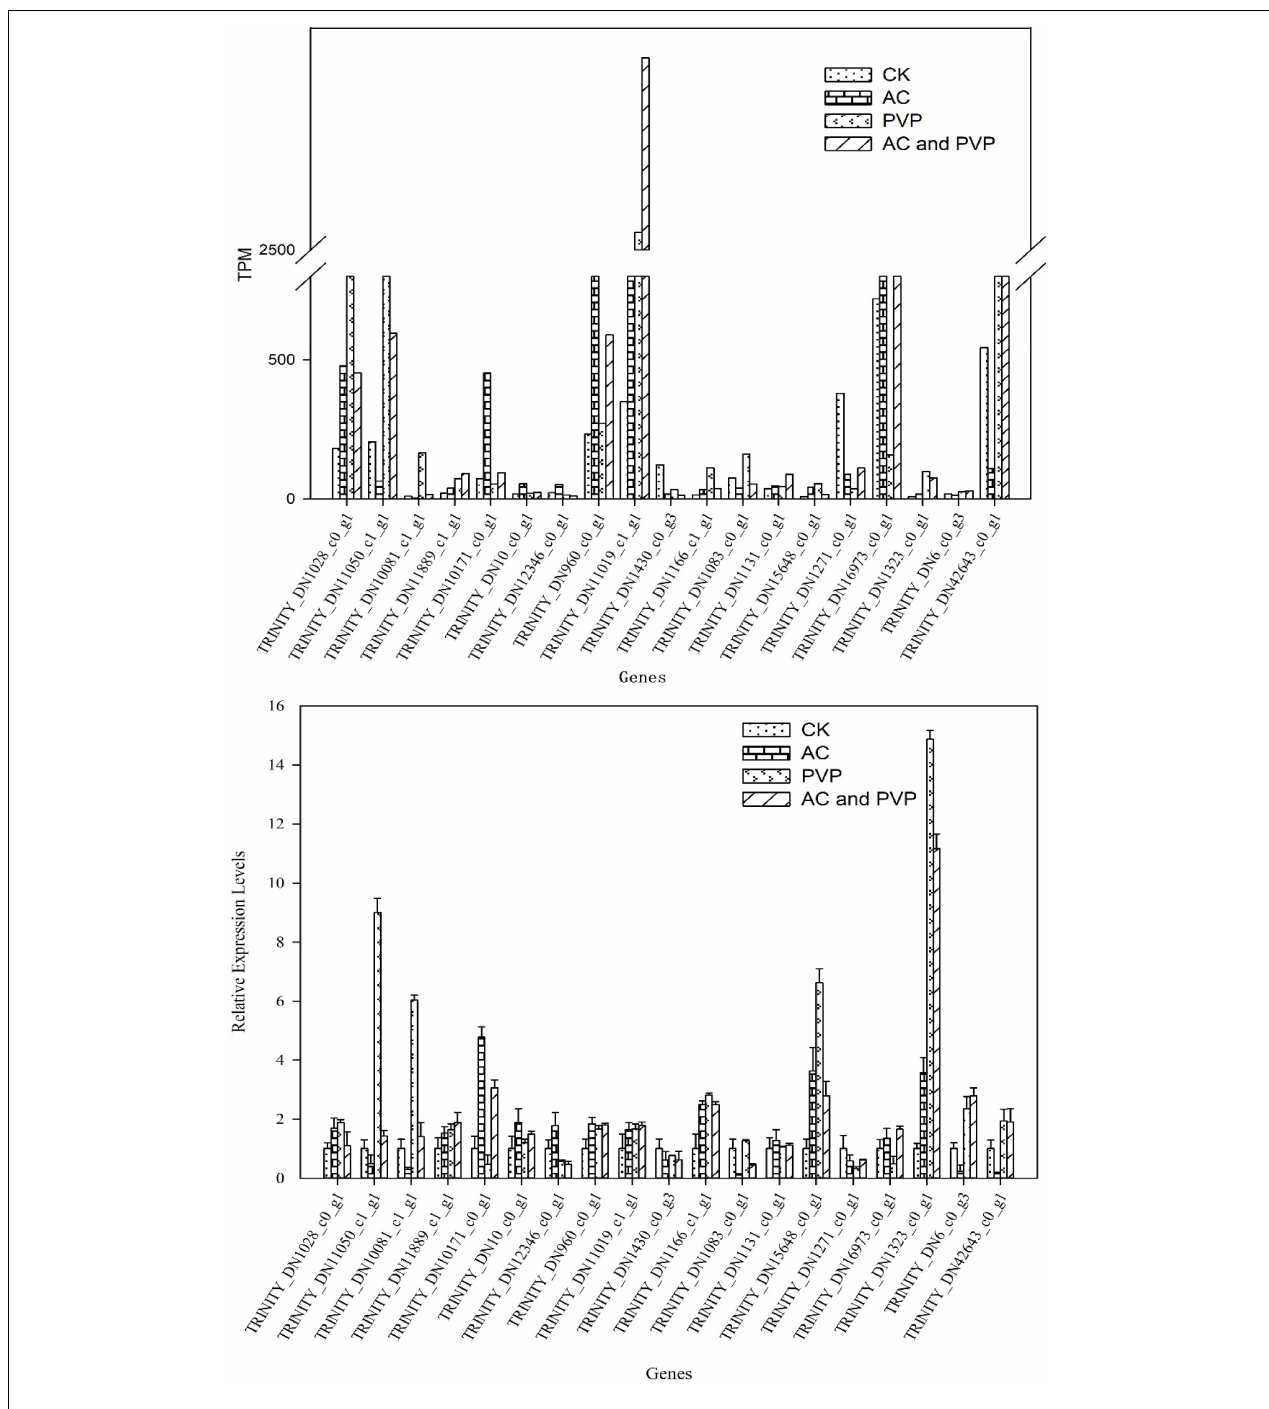
FIGURE 8 | Transcripts per million expression value and qRT-PCR relative expression of